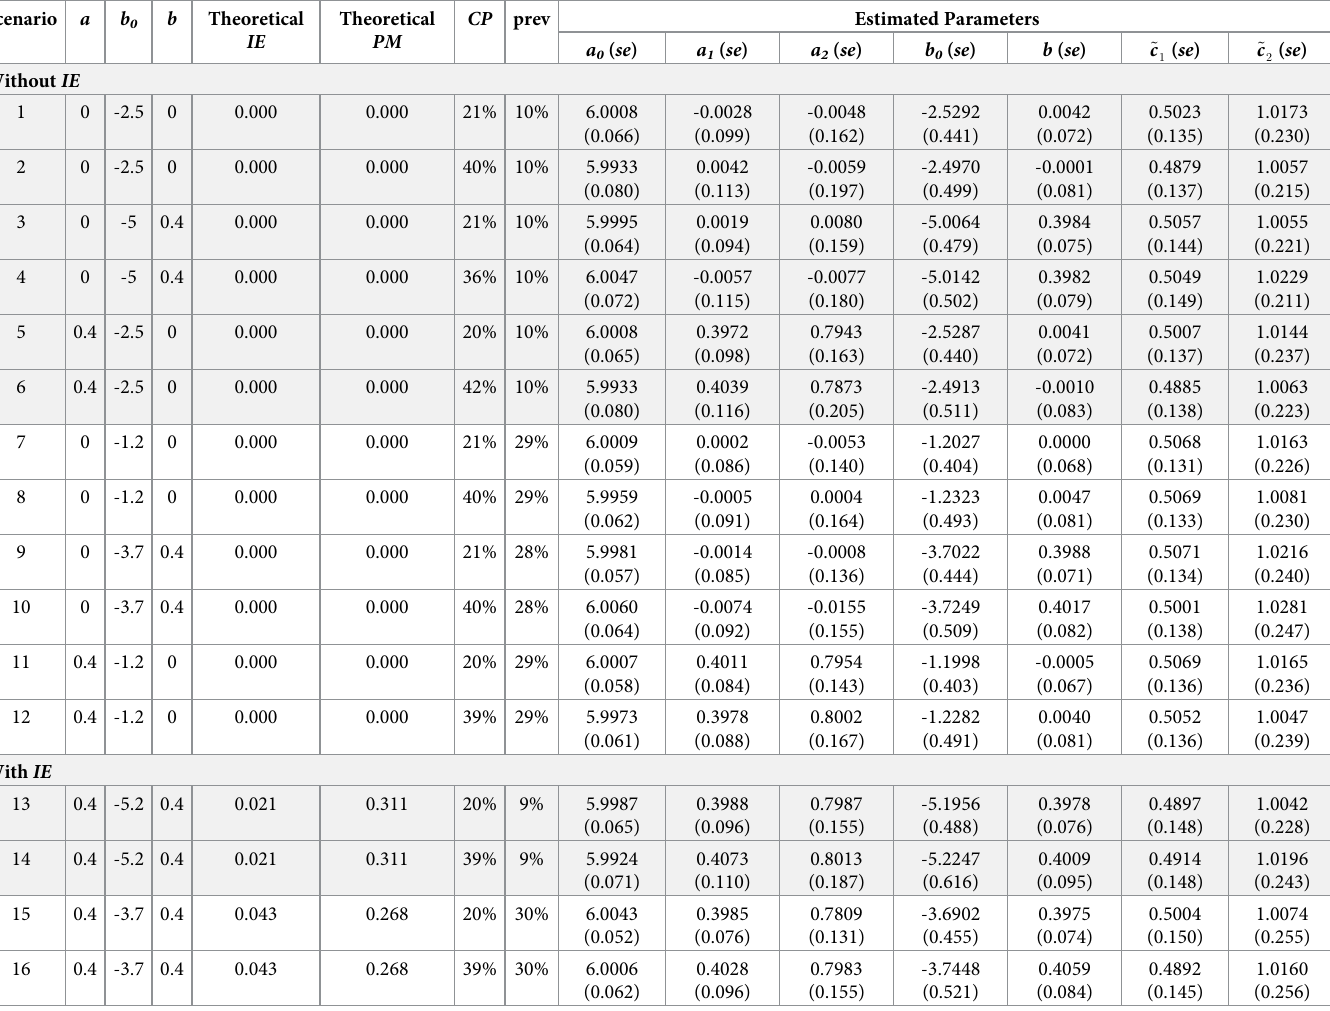
Table 1. Binary outcome: Means and standard errors (se) of estimated coefficients for different paths, a 0 , a 1 , a 2 , b 0 , b , ~ c (MAF) = 0.3.